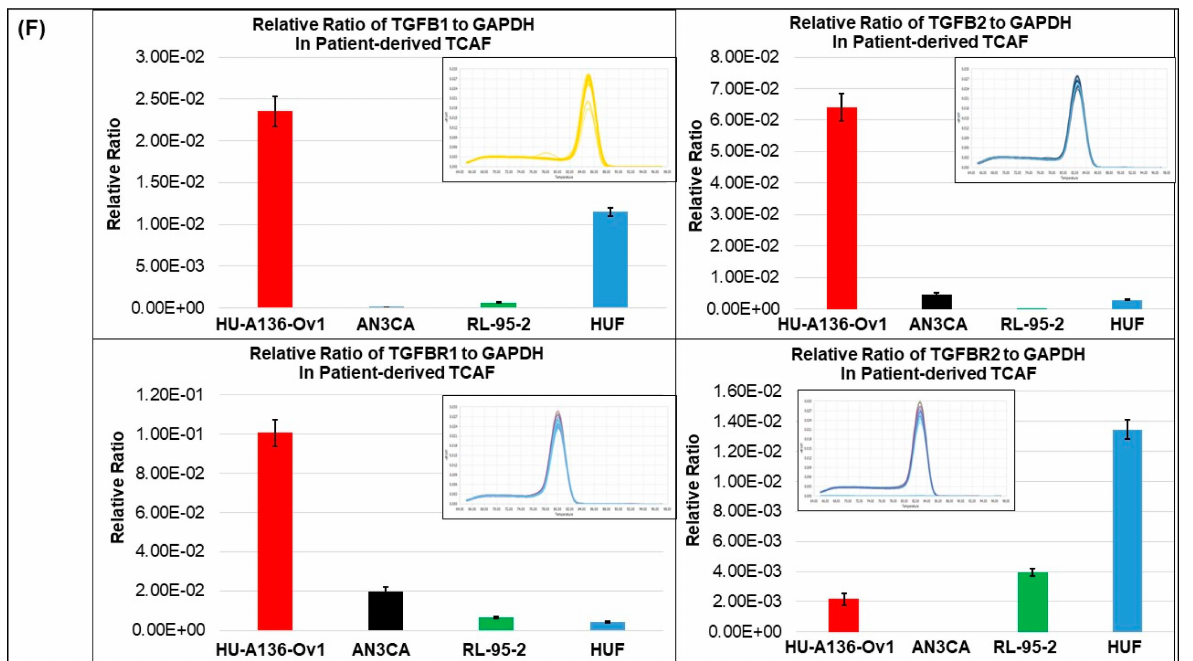
Figure 3. Expression of mRNA for positive and negative CAF markers in the Patient-Derived primary culture of ovarian CAF established from the representative tumor sample of ovarian cancers: We tested the expression of mRNA for SMA, CD90, PDGFRA and FAP-A ( A ), PD-L1, S100A4, and CD44 ( B ), EpCAM, CD45, and CD31 ( C ) in the tumor-derived CAF from the patient with grade 1, stage IVA low-grade appendiceal mucinous neoplasm and SMA, FAP-A, and S100A4 ( D ), EpCAM, CD45, and CD31 ( E ) and TGFB1, TGFB2, TGFBR1 and TGFBR2 ( F ) in the tumor-derived CAF from the patient with stage IA adult granulosa cell tumor. Bars in red color represent CAF derived from the tumor tissue, bars in green color represent the RL-95-2 endometrial cancer cell line, bars in blue color represent HUF, bars in dark blue color represent the MDA-MB-231 breast cancer cell line, bars in mustard color represent HUVEC endothelial cell line, bars in ash color represents HCC1954 breast cancer cell line, bars in orange color represents human PBMC, bars in dark violet color represents SKOV3 ovarian cancer cell line, bars in black color represents AN3CA endometrial cancer cell line. The melting curves are presented as the inset in each bar